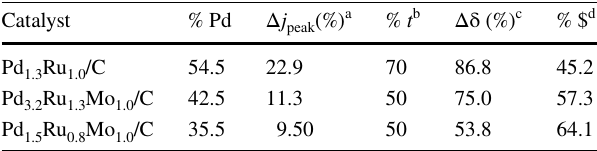
Table 5 Comparison between the results obtained for Pd Pd